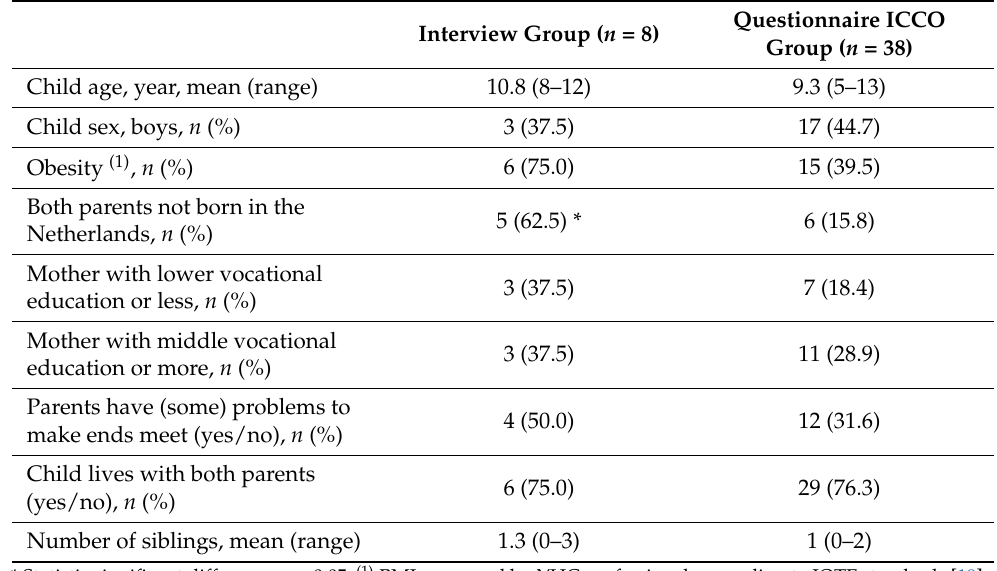
Table 1. Characteristics of participants; interviews and